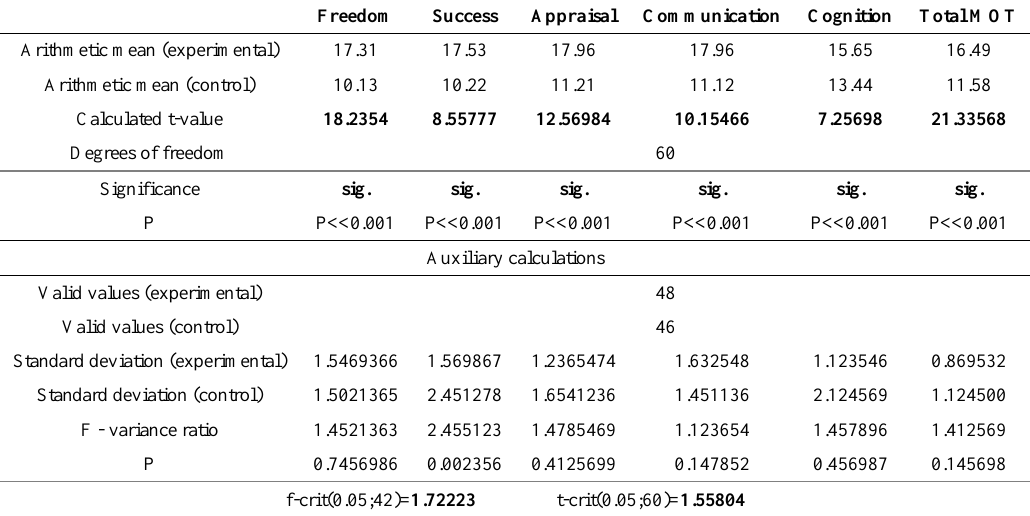
Table 7. T-test for MOTIVATION (Freedom, Success, Appraisal, Communication, Cognition)